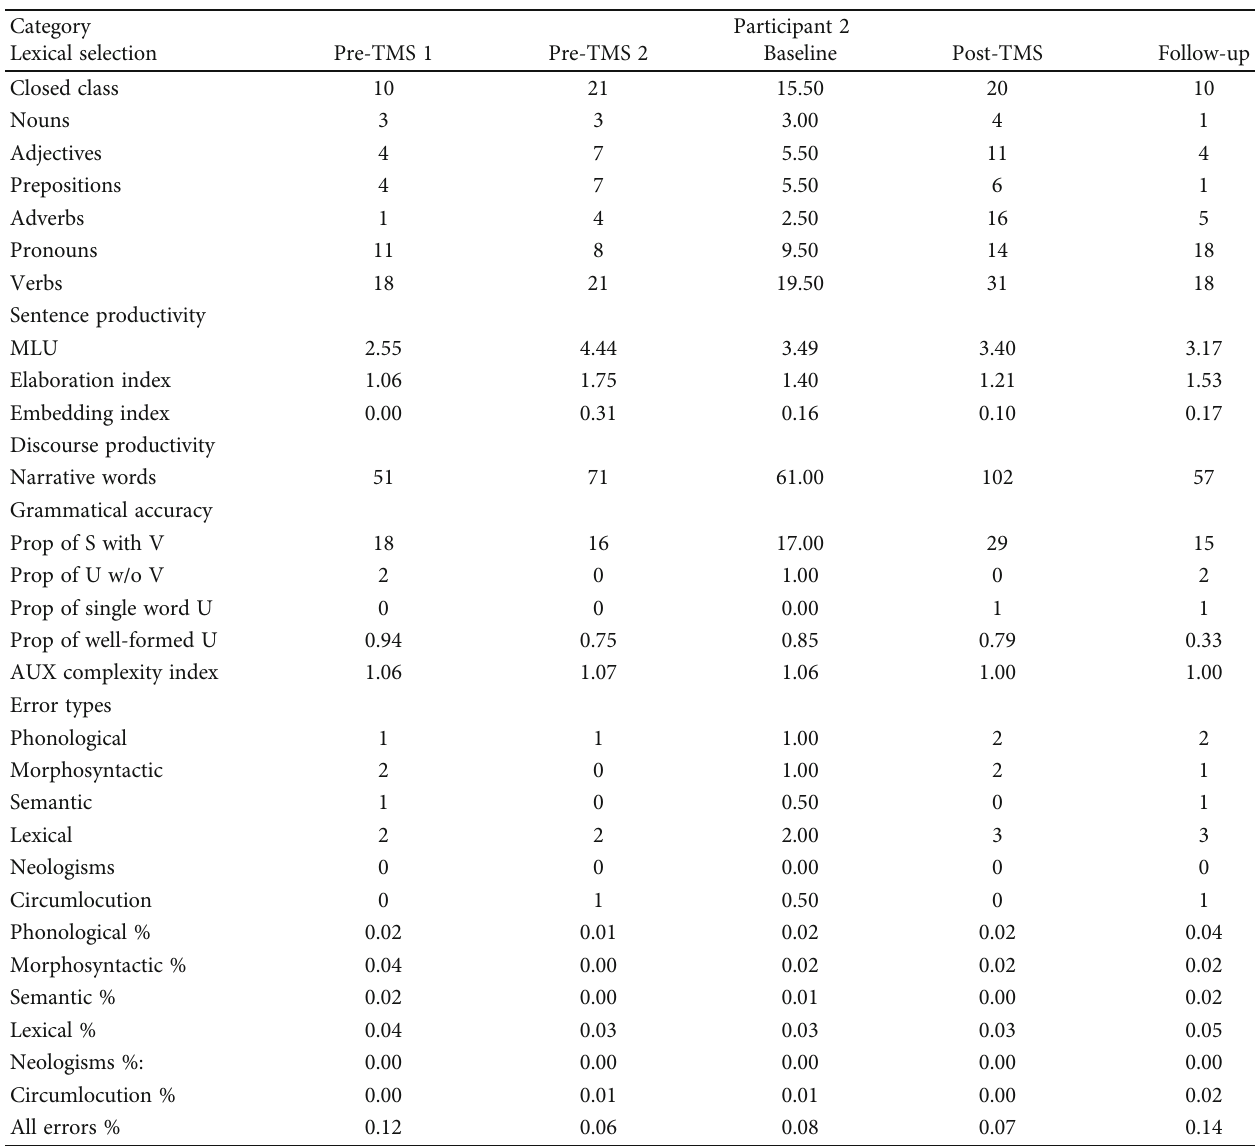
Table 4: Short-term (one day posttreatment) and long-term (two months posttreatment) e ff ects of cTBS on narration outcomes (i.e., functional communication) for participant